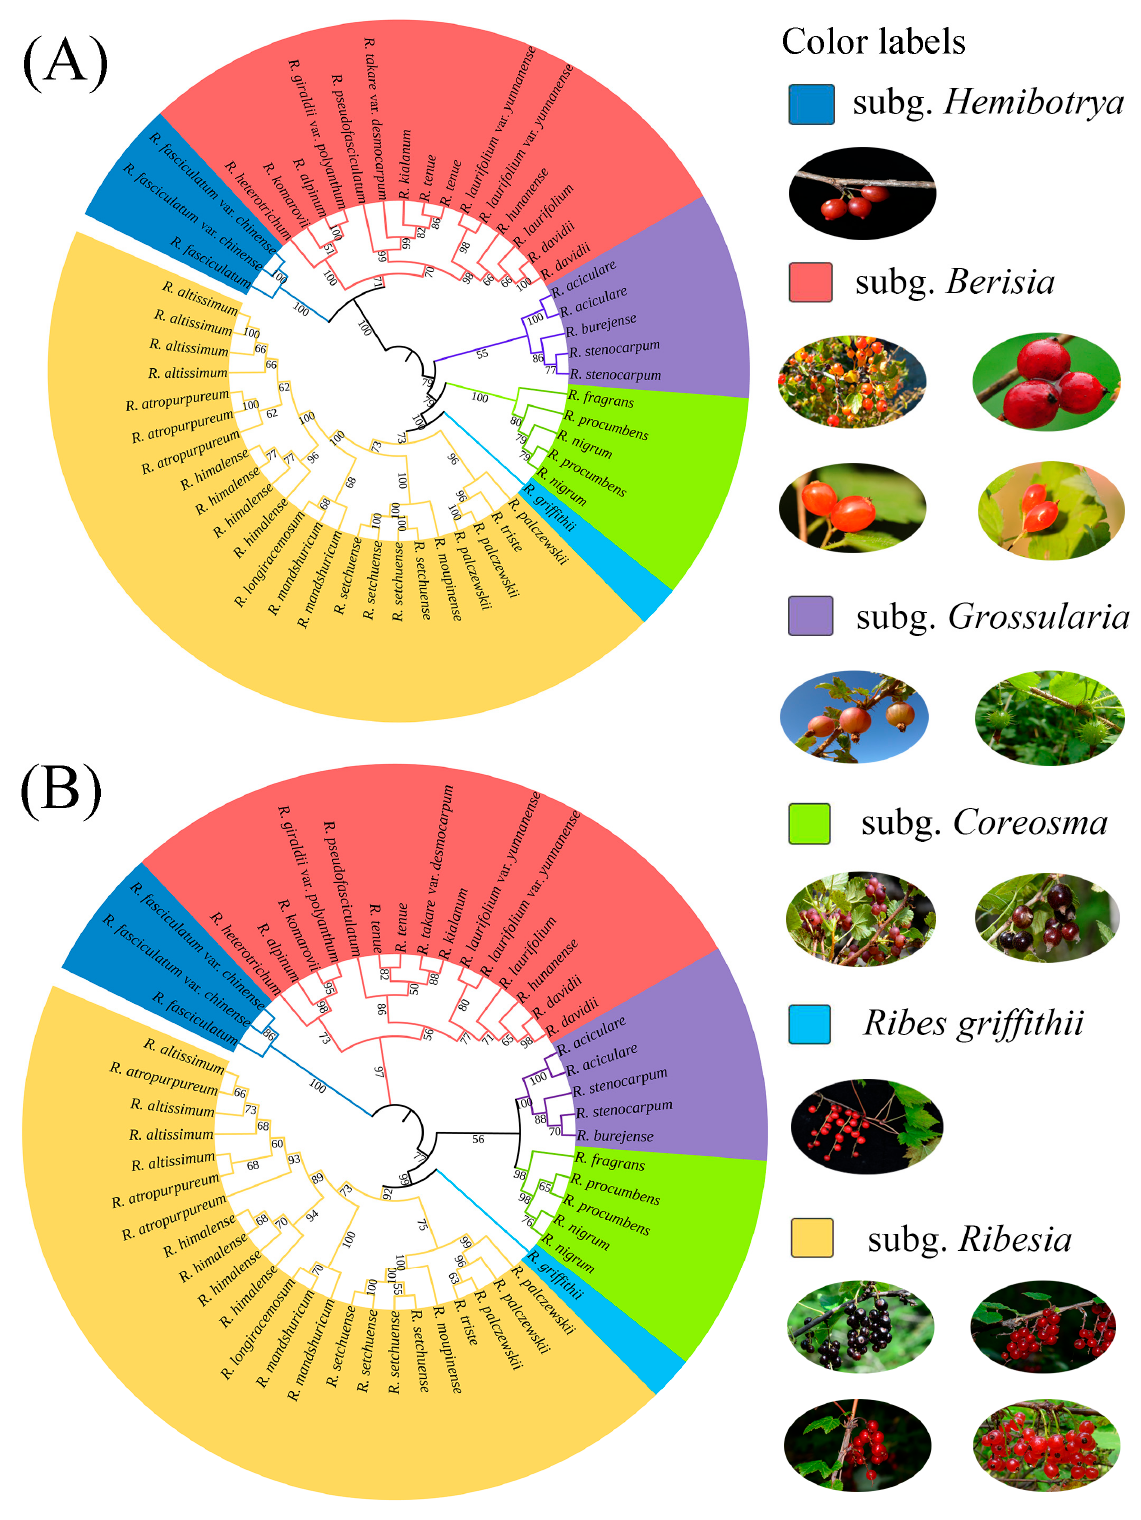
Figure 1. Neighbor-joining phylogenetic tree ( A ) and maximum likelihood phylogenetic tree ( B ) were reconstructed with bootstrap values calculated through 1000 iterations based on 2,451,454 identified SNPs. The numbers on the branches are the related bootstrap supports. Dark blue—subg. Hemibotrya , red—subg. Berisia , purple—subg. Grossularia , green—subg. Coreosma , light blue— Ribes griffithii , yellow—subg. Ribesia .